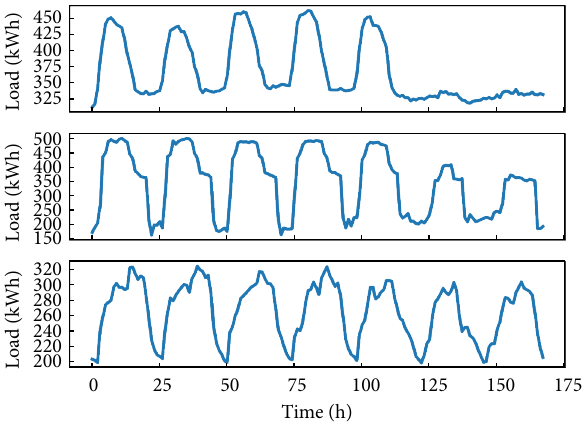
Fig. 1 Different electricity consumption patterns of different buildings. (up: one education building, mid: one public building, down: one lodging build-